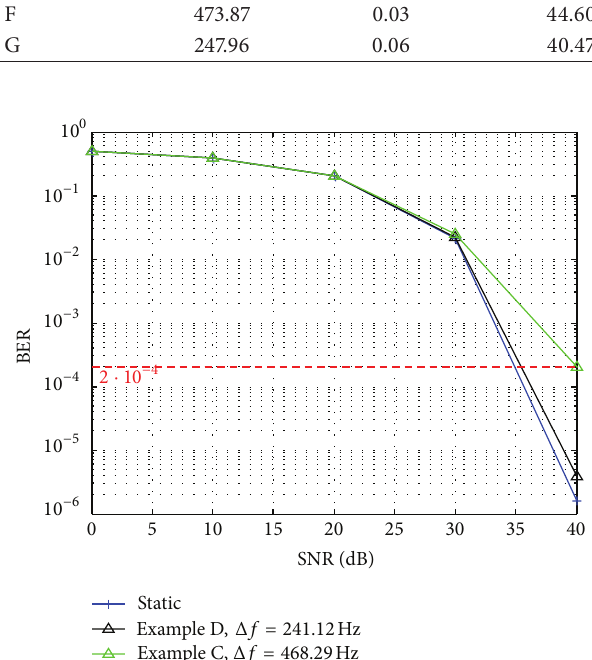
Figure 6: BER versus SNR curves for the static case and the empir- ical Doppler spectra of Examples C and D.